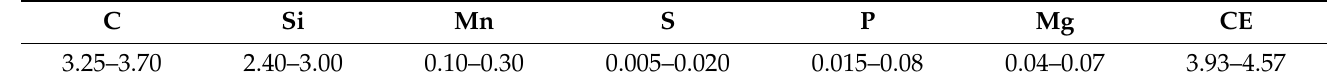
Table 1. Cast iron